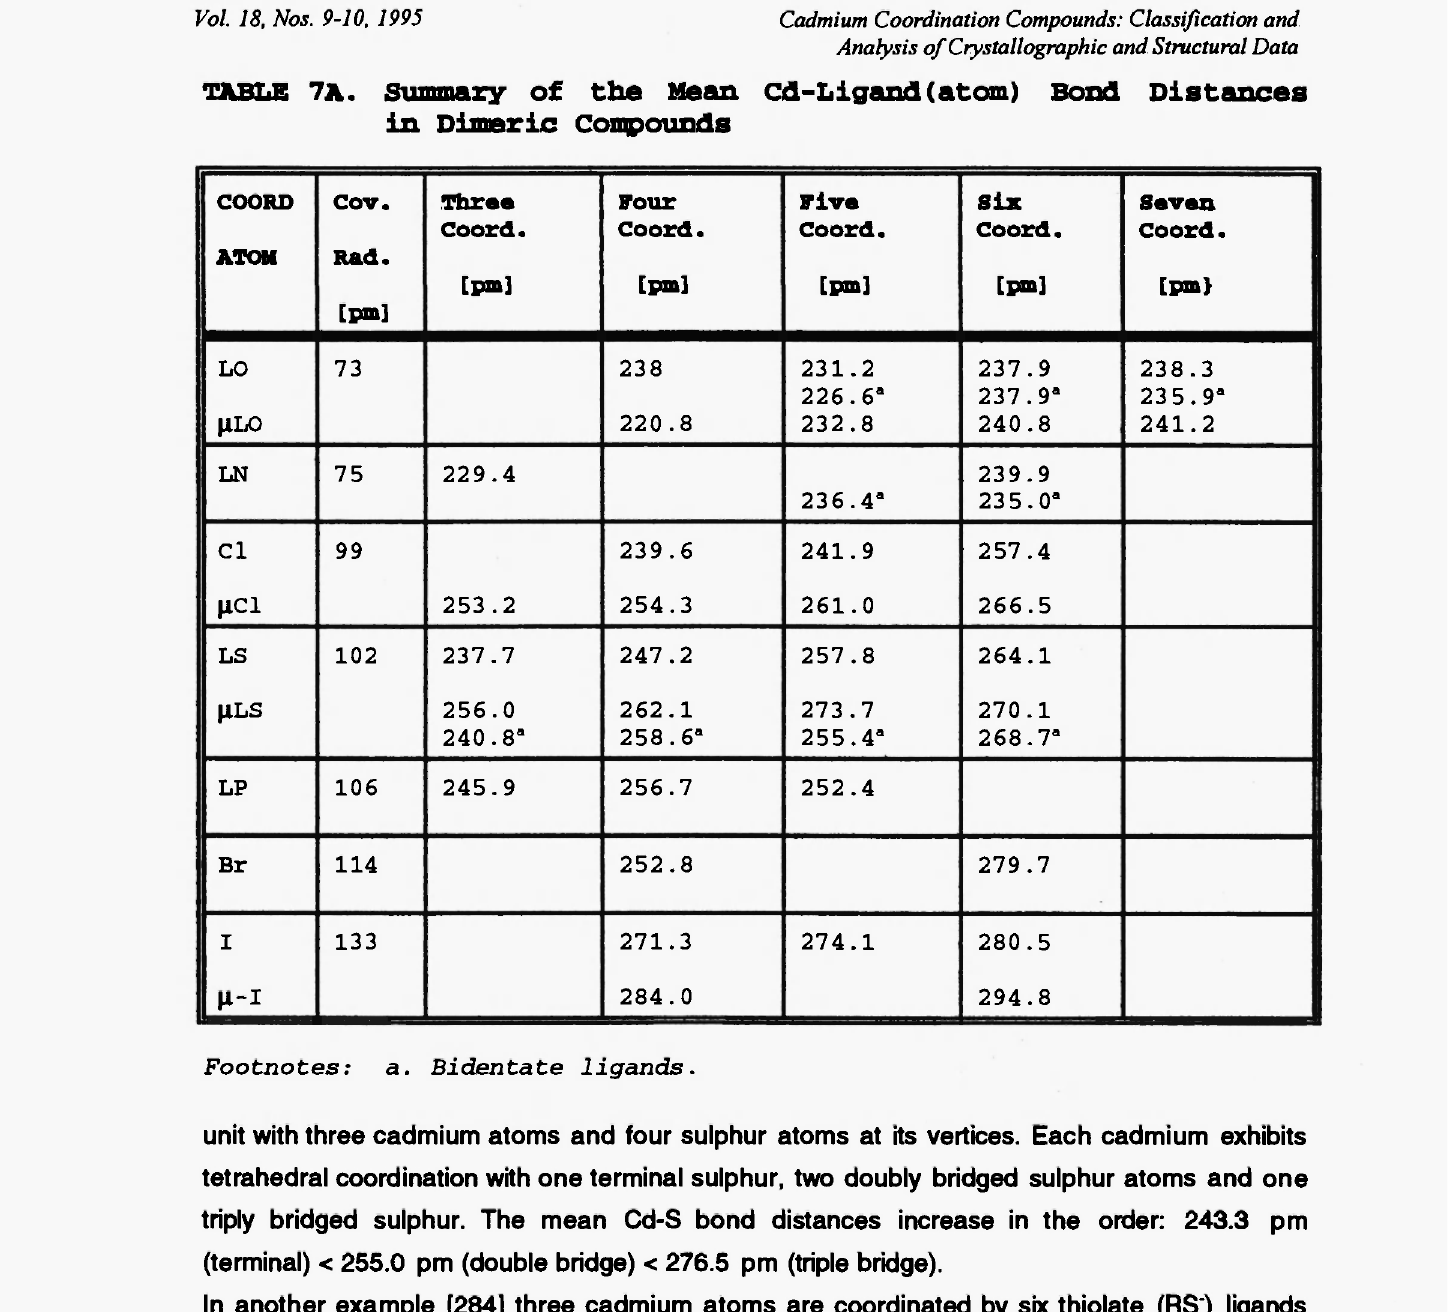
TABLE 7A. Summary